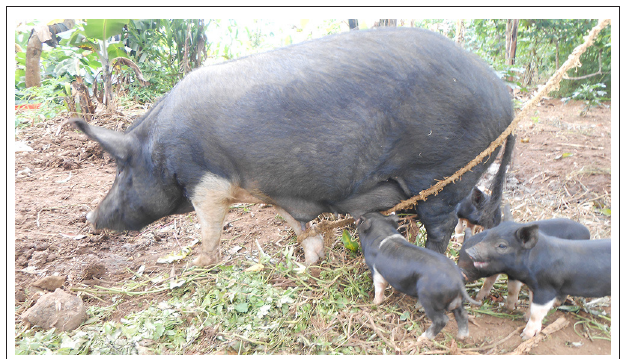
FIGURE 2 | Tethered sow with piglets in Uganda (picture credit: Michel Dione, ILRI).